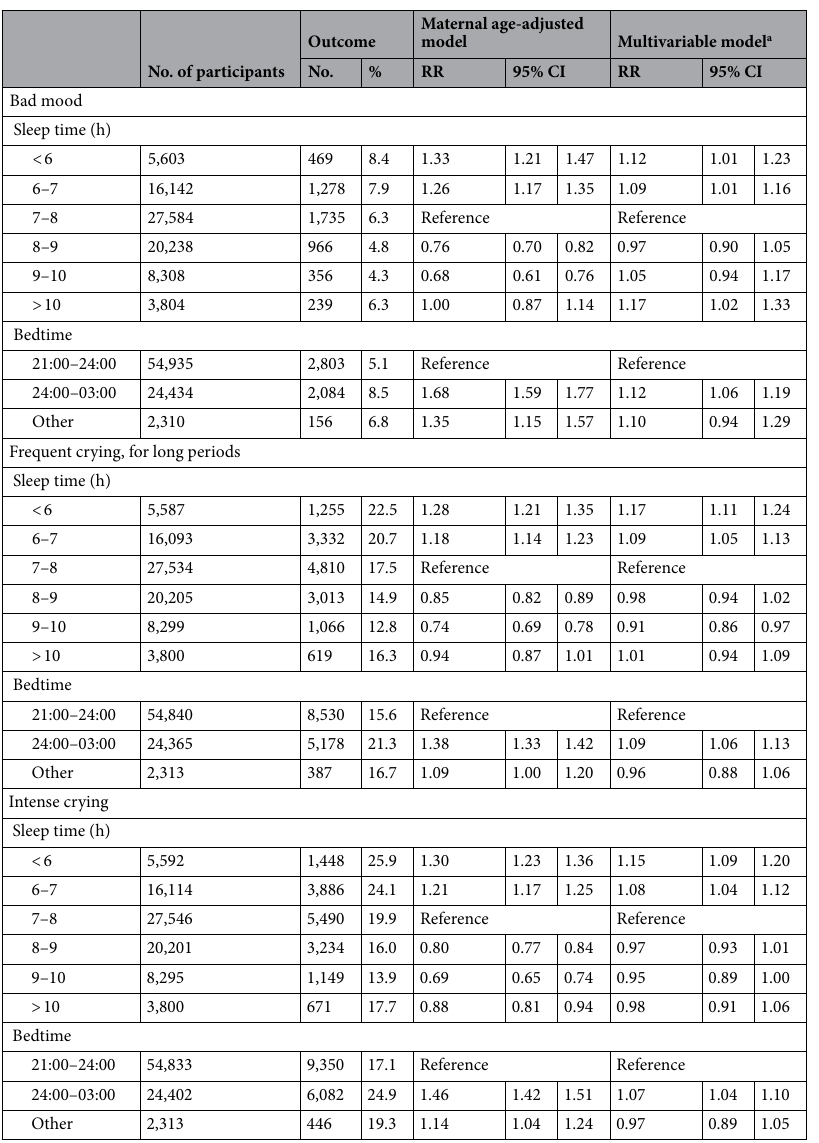
Table 6. Association between sleep during preconception and neonatal irritability in the Japan Environment and Children’s Study (2011–2014). CI, confidence interval; RR, relative risk. a Adjusted for maternal age at delivery, smoking habits, alcohol consumption, pre-pregnancy body mass index, gestational age at birth, parity, infertility treatment, infant sex, small for gestational age, type of delivery, and postpartum depressive symptoms.